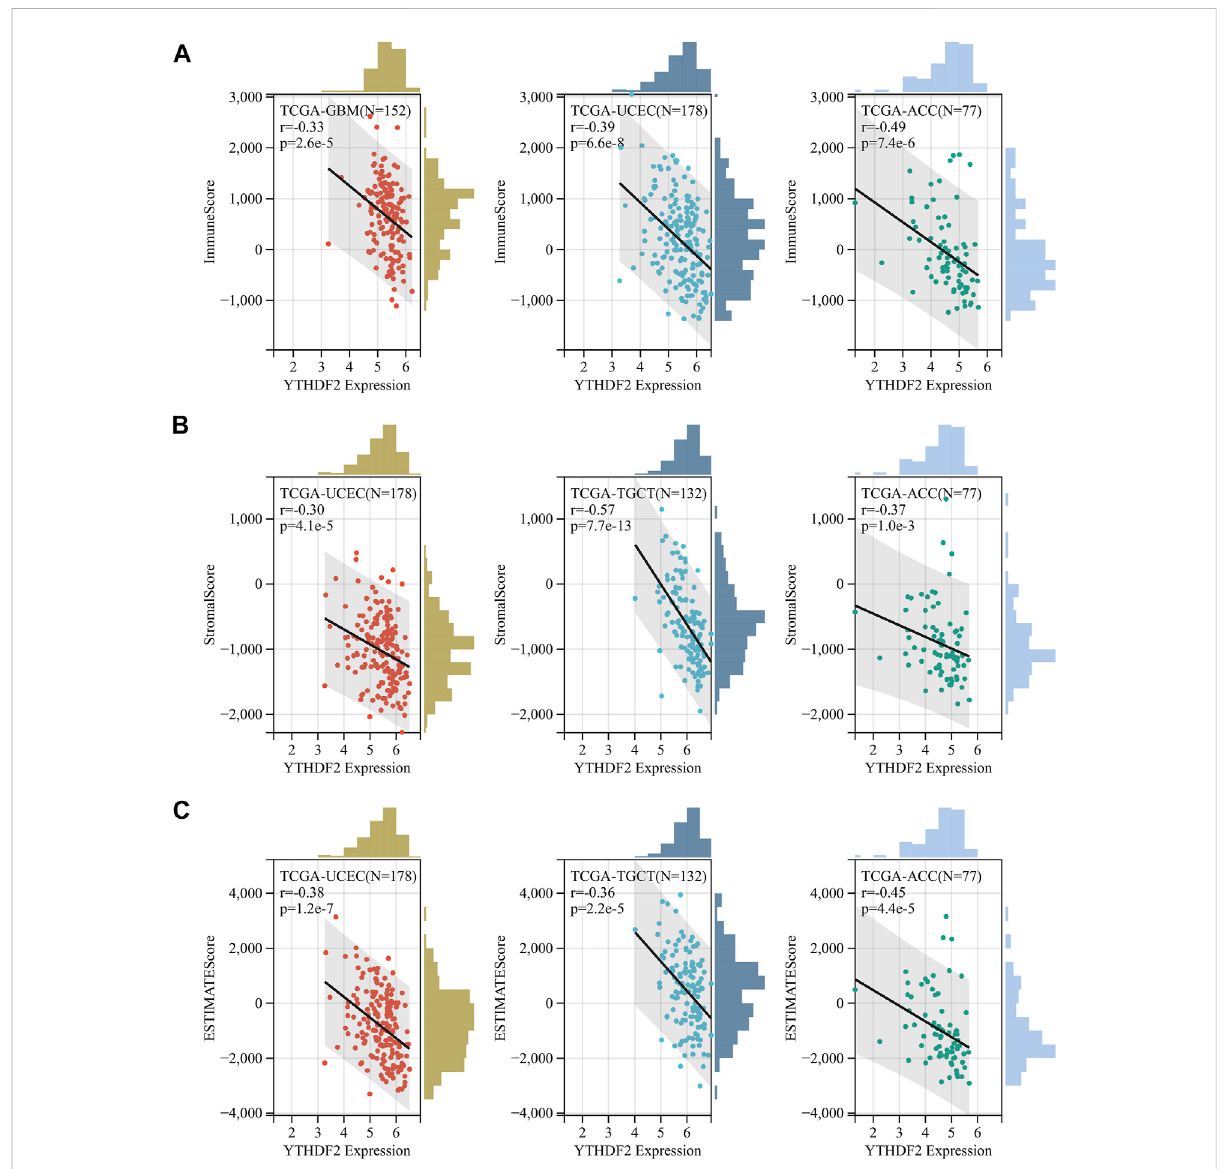
FIGURE 5 The correlation between YTHDF2 expression and immuneScore, stromalscore and estimatescore in GBM, UCEC and ACC. (A) the correlation between YTHDF2 expression and Immunescore in UCEC, TGCT, and ACC. (B) The correlation between YTHDF2 expression and stromalscore in UCEC, TGCT and ACC. (C) The correlation between YTHDF2 expression and estimatescore in GBM, UCEC and ACC.